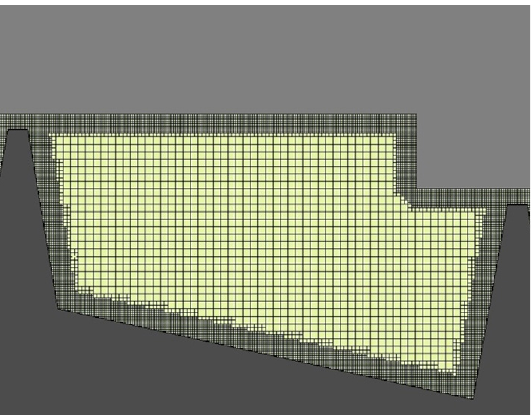
Figure 7. the mesh created by the “CONVERGE CFD“ solver for the stepped labyrinth seal.